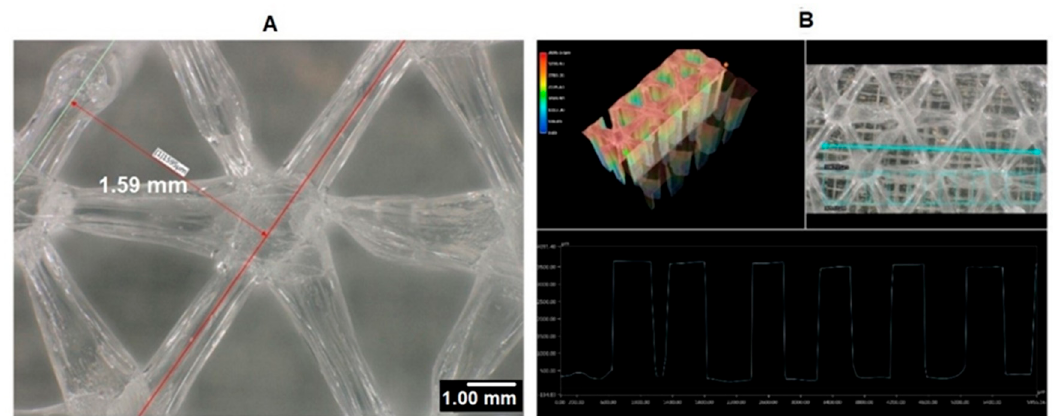
Figure 6. ( A ) Microscopic picture from top view of the 3D-printed sample with 1.6 mm ILD at 100× magnification setting. ( B ) 3D profile of the 3D-printed sample with 1.6 mm ILD at the 100× magnification setting.